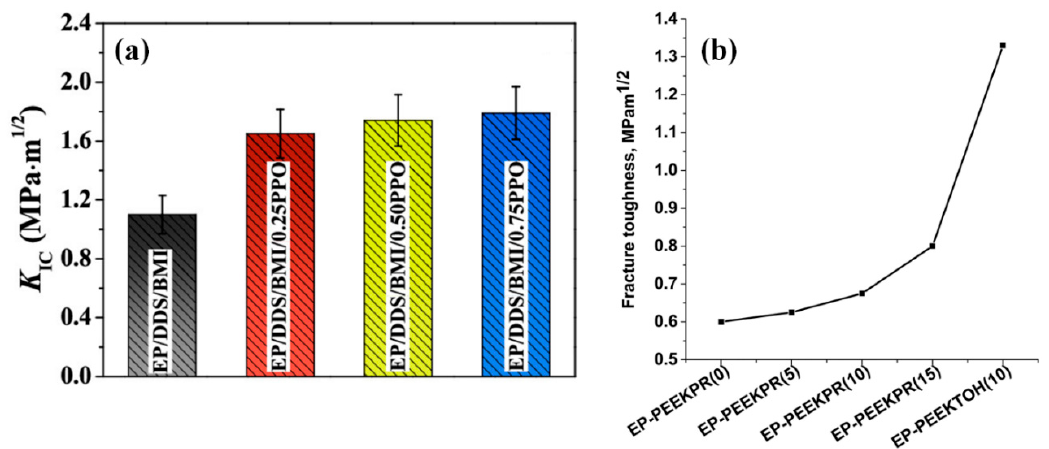
Figure 4. ( a ) Fracture toughness of neat epoxy and epoxy system modified with different content of polyphenylene ether (PPO). Reprinted with permission from ref. [44], Copyright [2018], American Chemical Society, ( b ) fracture toughness of epoxy blends with PEEK-PR or PEEK-TOH. Reprinted with permission from ref. [38], Copyright [2019], John Wiley and